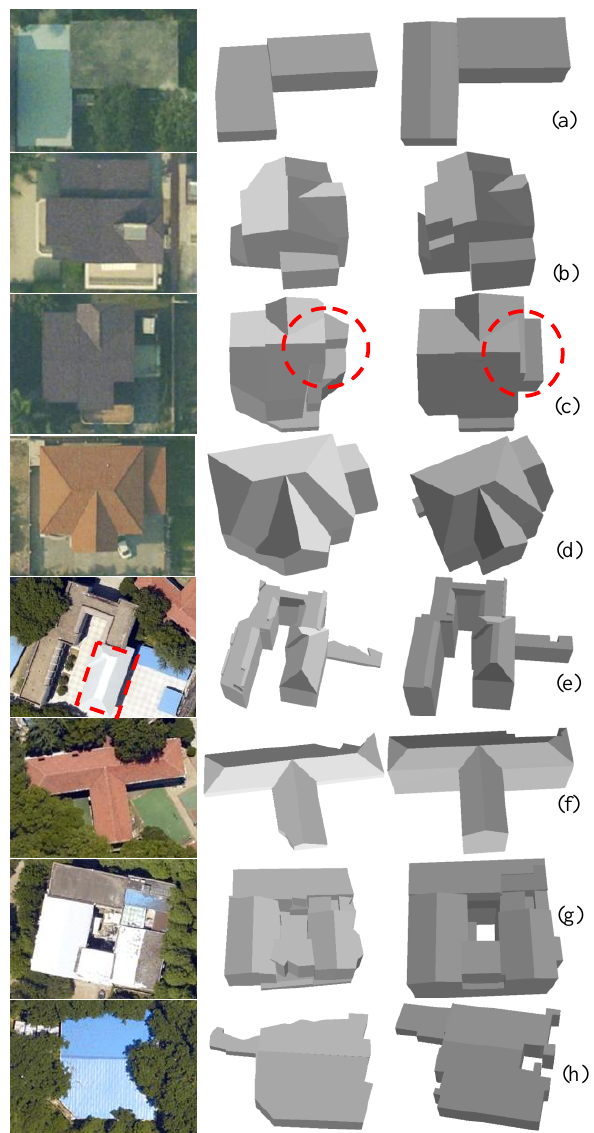
Figure 8. Comparison of roof model reconstruction. From left to right: images, results from the graph matching approach, and results from our global solution. (a-d): Yangjiang, (e-h): Wuhan.